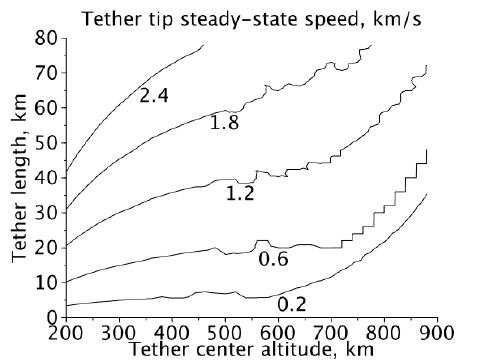
Figure 4. Steady-state tip speed of the rotating tether on the equatorial circular orbit in average solar conditions (based on MSISE-90 atmospheric model).